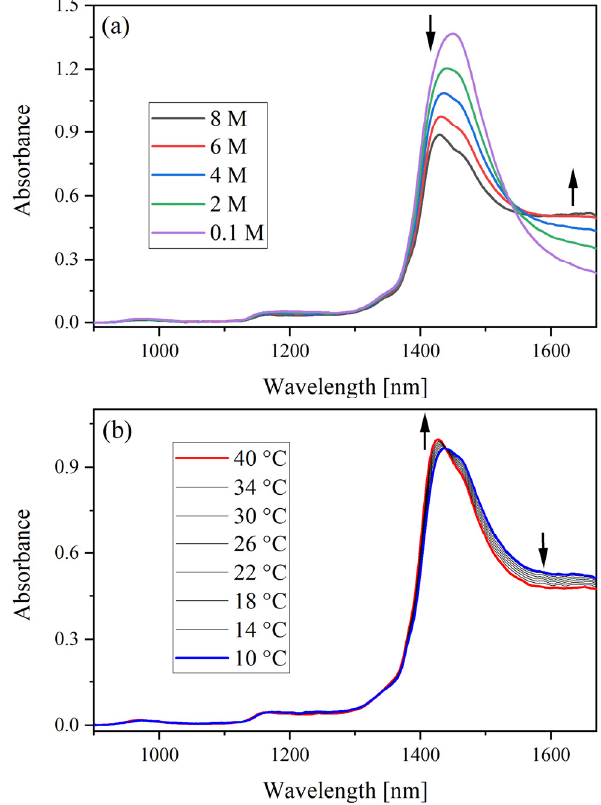
Figure 1. NIR absorbance spectrum of ( a ) 0.1–8 M HNO 3 at 24 °C and ( b ) 6 M HNO 3 from 10–40 °C. Arrows note the direction of spectral change as the concentration or temperature was increased. The spectrometer was blanked in air, and the optical path length was 1 mm. Table 1. D-optimal selected HNO 3 and temperature levels with space and build types. Run Acid (M) Temp. ( ◦ C)